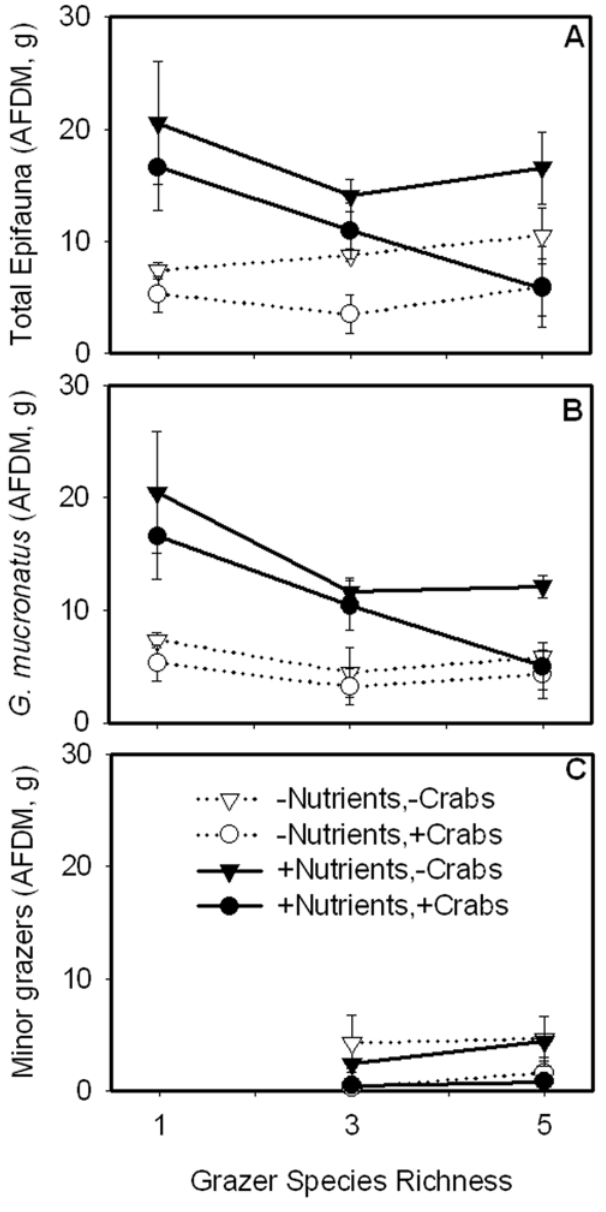
Figure 2. The effects of nutrient enrichment and crab presence on grazer biomass. Total epifaunal biomass (A) was divided into two categories: G. mucronatus -only and ‘minor grazers’. Nutrient enrichment increased the biomass of G. mucronatus (B) while crab predators reduced the abundance of minor grazers (C).